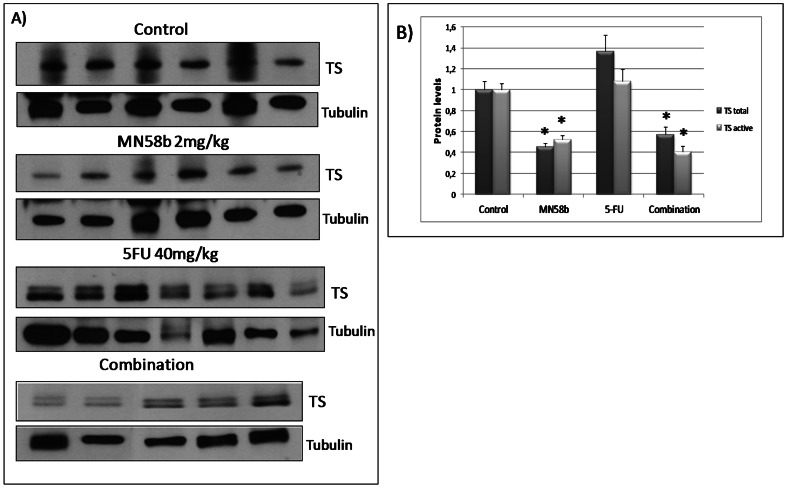
TS expression levels in tumor tissues from DLD-1 xenografts after treatment with MN58b plus 5-FU.Mice were inoculated with DLD-1 cells as indicated under Materials and Methods and either left untreated, or treated with MN58b or 5-FU alone or in combination. A) TS expression levels of each experiment group: Control, MN58b, 5-FU and combination group. Tubulin was used as loading control. B) Graph represents mean protein levels as TS/tubulin ratios for each group. Black bars represent total TS/tubulin values; Grey bars represent TS active values. (*) Statistically significant (p<0.05), compared to control group.